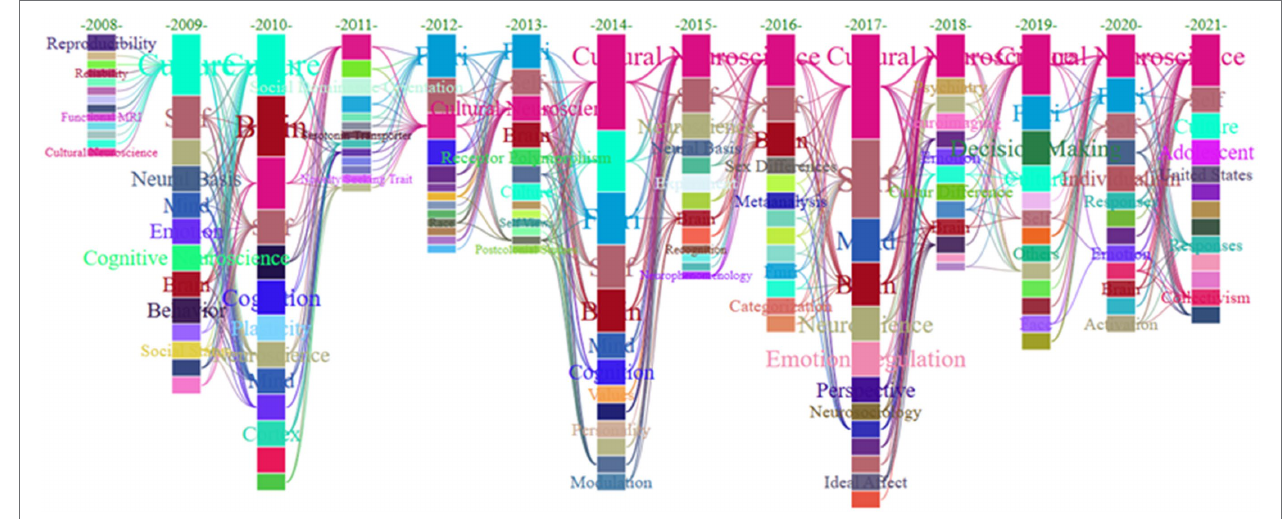
FIGURE 7 | Theme evolution